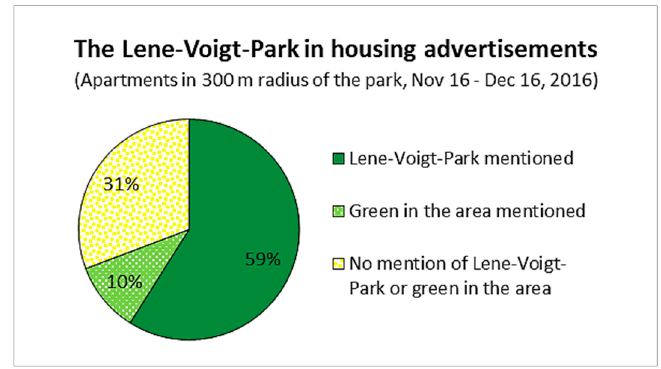
Figure 5. Mentioning of the Lene-Voigt-Park (LVP) in housing advertisements (data sources: [89]).